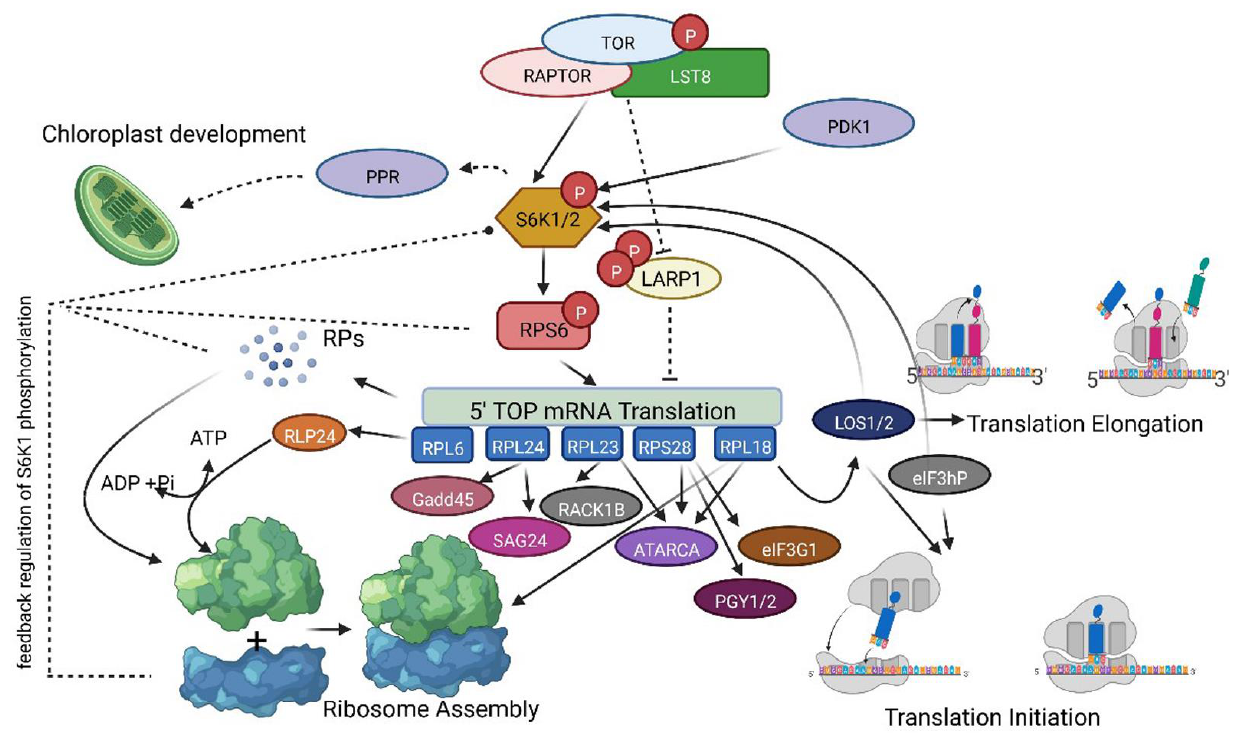
Figure 6. Possible feedback regulation of S6K1 phosphorylation via the TOR pathway. An illustration of TOR Complex 1-mediated regulation of S6K1 phosphorylation and translational initiation by further phosphorylation and activation of RPS6 protein and other RPL and RPS proteins. Dashed lines represent signaling pathways or intermediates that are not fully revealed. The observations from the predicted PPI networks and the inhibition of RP genes suggest that the S6K1 phosphorylation is differentially regulated. Possibly, the TOR and RPs are interlinked for the regulation of S6K1 phosphorylation, where RPs also have an independent role in differentially regulating the S6K phosphorylation and modulating protein translation in the plant cell. The figure represents a model for the regulation of S6K1 phosphorylation by loss of RPs in plants, which is possibly mediated via the association of RPs with the S6K1 protein or the other regulatory proteins in the TOR pathway. The illustration was created using www.biorender.com (accessed on 21 December 2022) and exported using a free trial subscription.